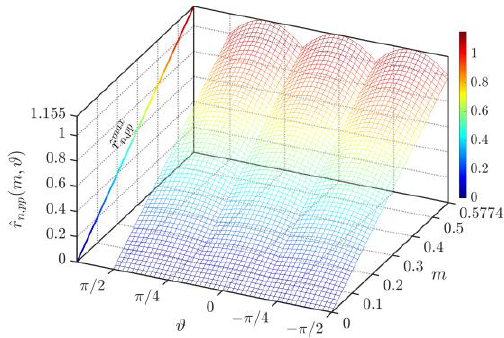
Figure 30. Normalized primary peak-to-peak neutral current ripple profile.